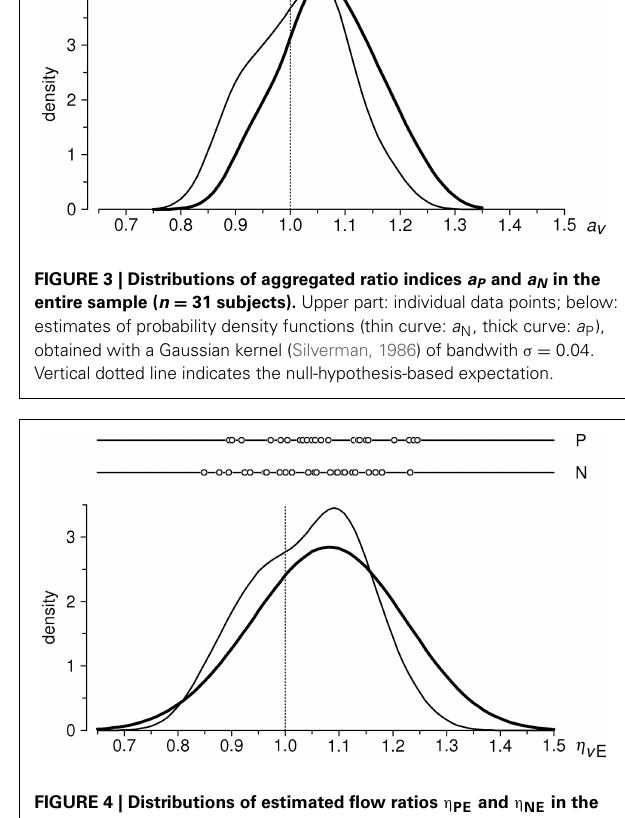
FIGURE 4 | Distributions of estimated flow ratios η PE and η NE in the cleaned sample ( n = 26 subjects). Upper part: individual data points; below: estimates of probability density functions (thin curve: η PE , thick curve: η NE ), obtained with the same method as in Figure 3 . Vertical dotted line indicates the null-hypothesis-based